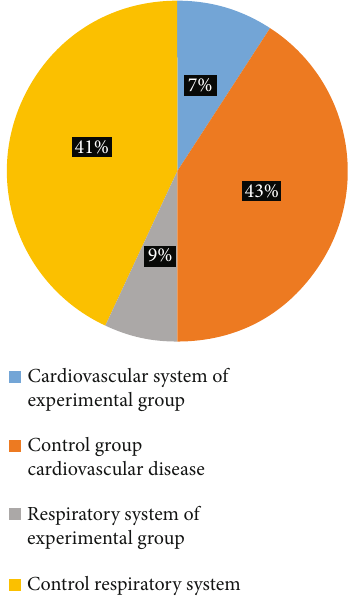
Figure 4: Comparison of somatization factors of college